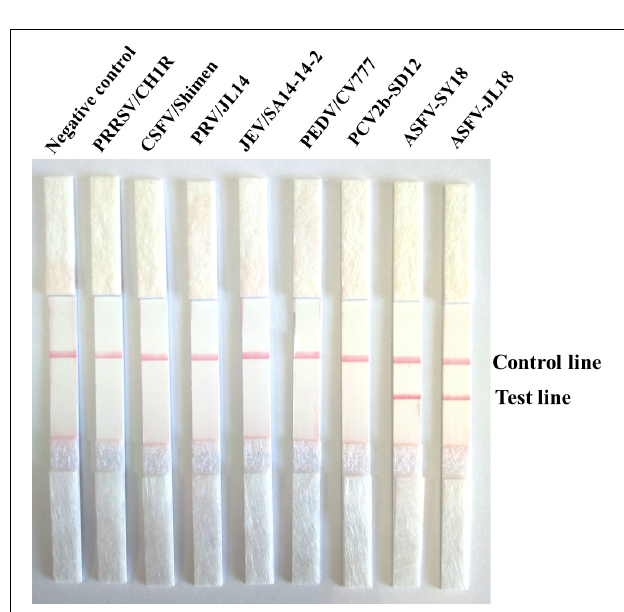
FIGURE 5 | Specificity test results of ASFV RPA-LFD assay involving Nano-magnetic bead DNA extraction from ASFV and other porcine